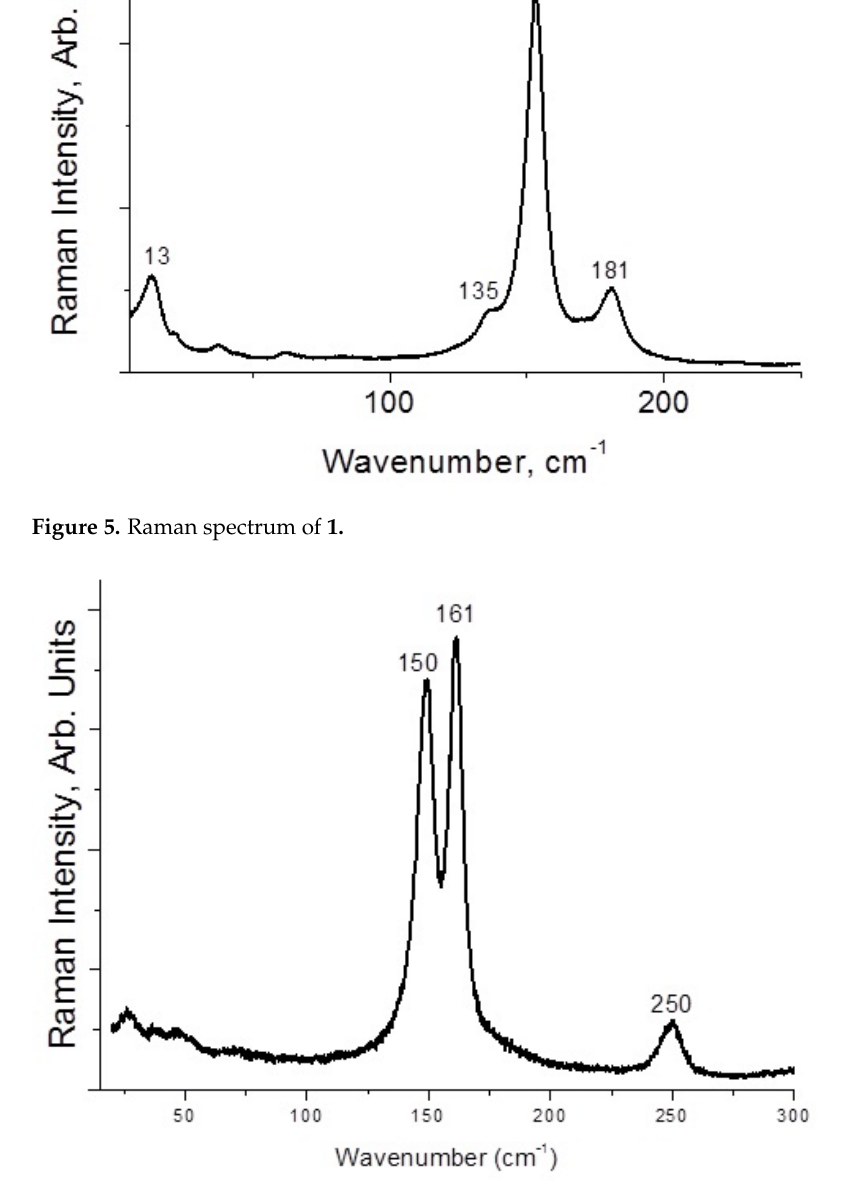
Figure 6. Raman spectrum of 2.